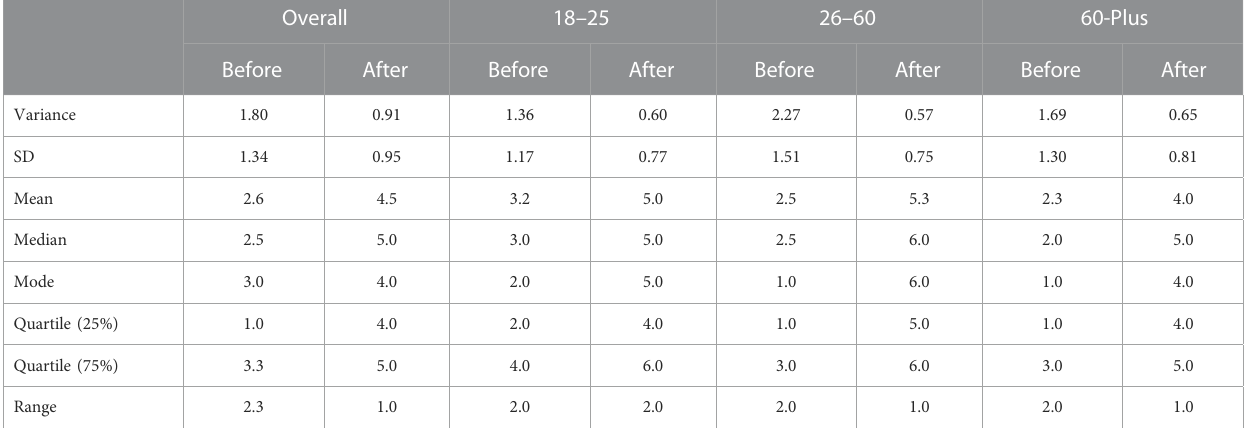
TABLE 2 Descriptive statistics of correct answers in Questionnaire A